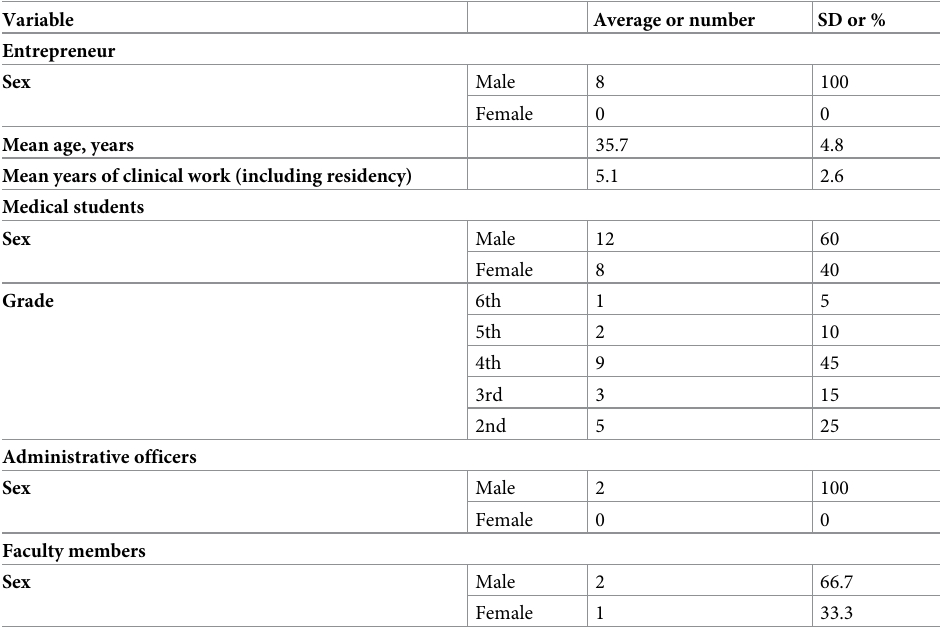
Table 1. Characteristics of physician